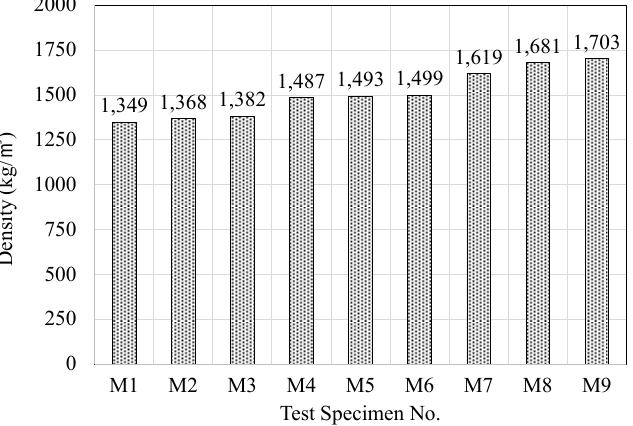
Test Specimen No. Test Specimen No. Figure 7. Variations of density according to mixing conditions. Figure 7. Variations of density according to mixing conditions. Figure 7. Variations of density according to mixing conditions.